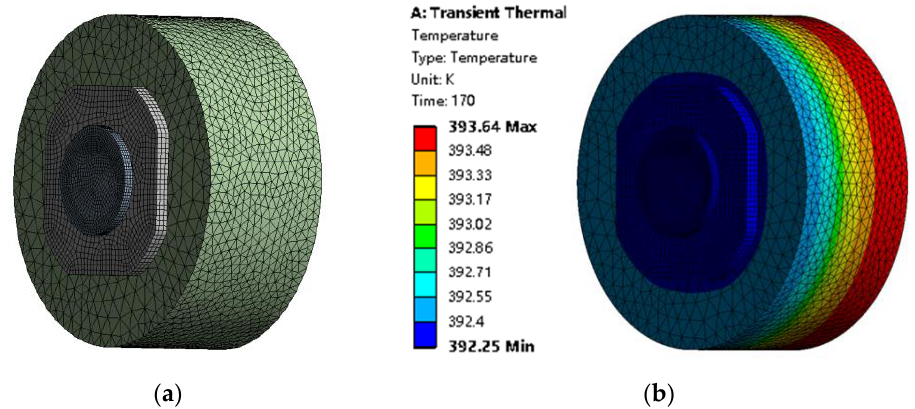
Figure 10. The heat transfer simulation of the outer annulus: ( a ) the grid model; ( b ) the T r2 simulation results at 6000 rpm.